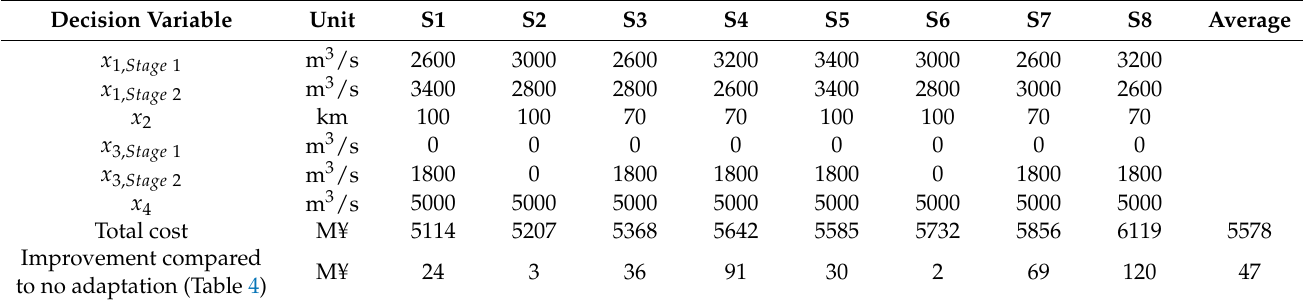
Table 8. Summary of the best combination of first and second stage decisions under each scenario (deterministic analysis). Decision Variable